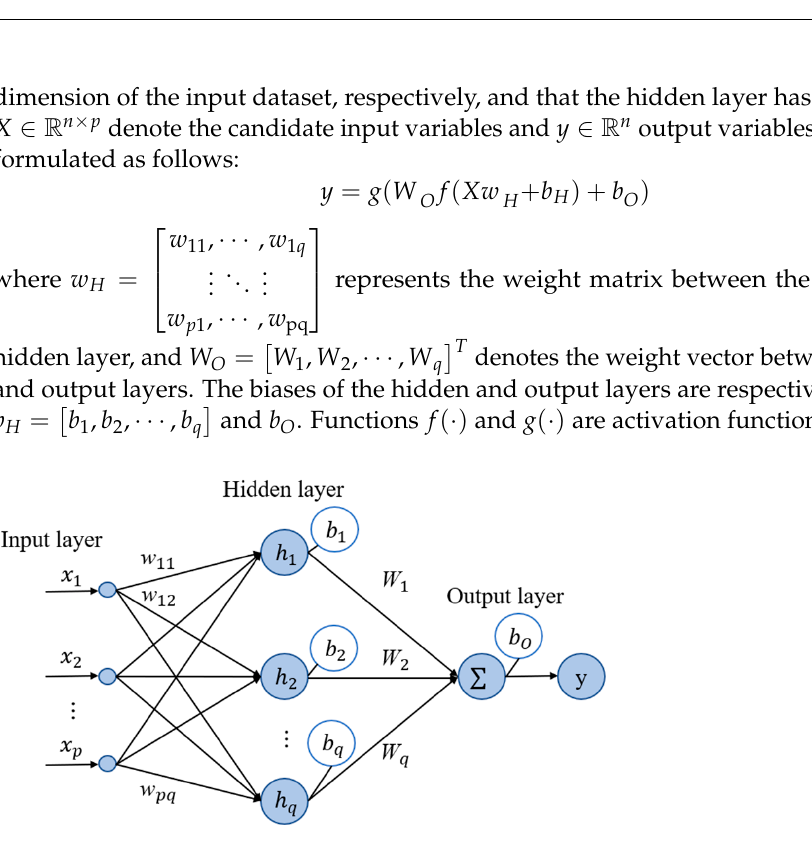
Figure 1. Structure of a three-layer MLP.